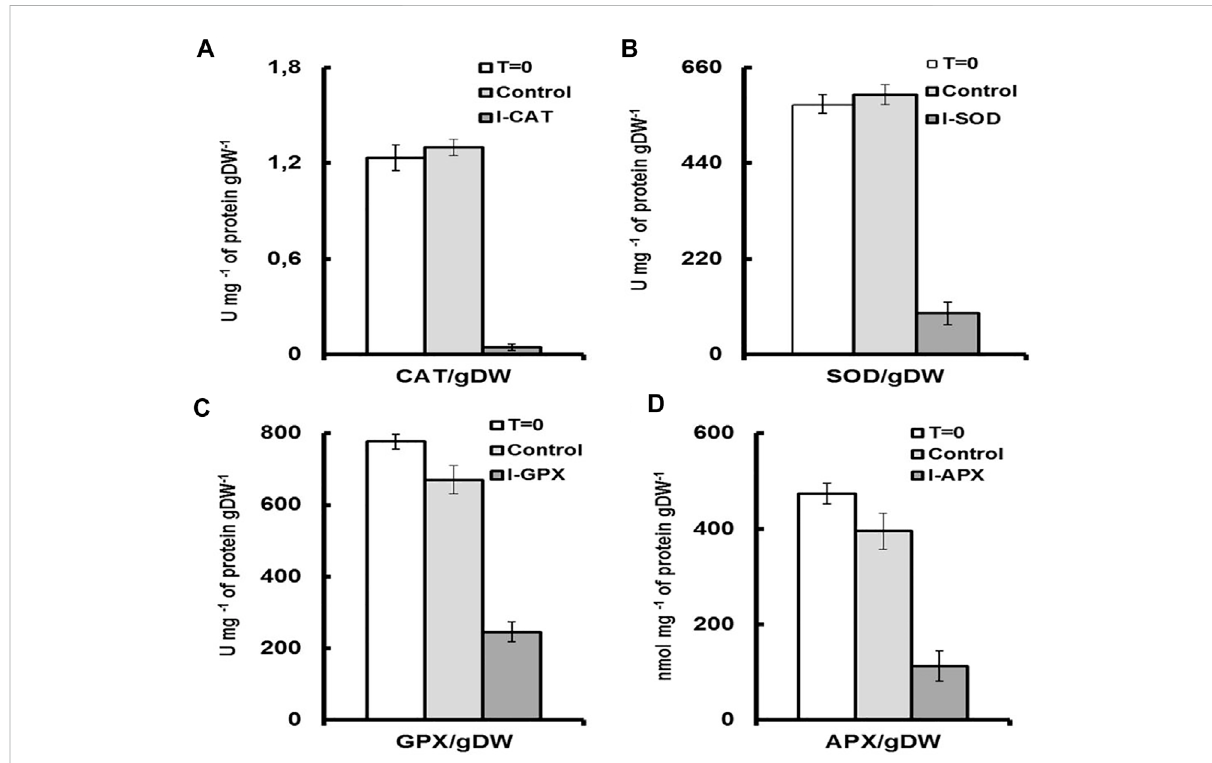
FIGURE 5 Enzymeactivitiesforeachculturemediumperunitofdrycellmass.T=0representstheenzymeactivityoninoculationperunitofdrycellmass. Control, representstheenzymaticactivityofthecontrolcultureonterminationperunitofdrycellmass.I-enzyme,representstheenzymaticactivity per unit of dry cell mass of the culture on termination. (A) is CAT activity. (B) is SOD activity. (C) is GPX activity (D) is APX